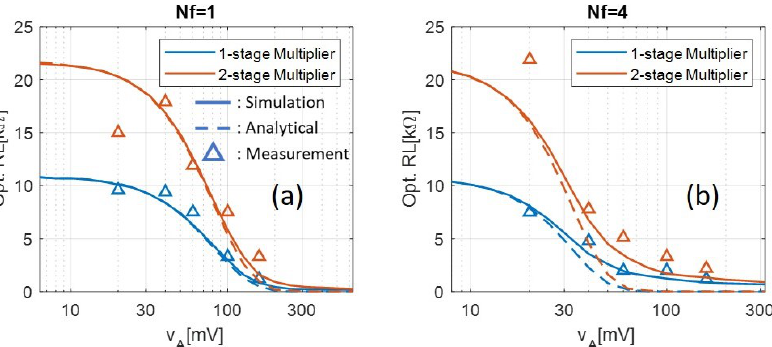
Figure 10. Optimal loads calculated by simulation, numerical solution of the analytical model, and measurement with ( a ) N f = 1 and ( b ) N f = 4. Note that the measured results with the lowest input tone amplitude v A tend to be outliers since the rectifier’s output voltage is close to the noise floor of the